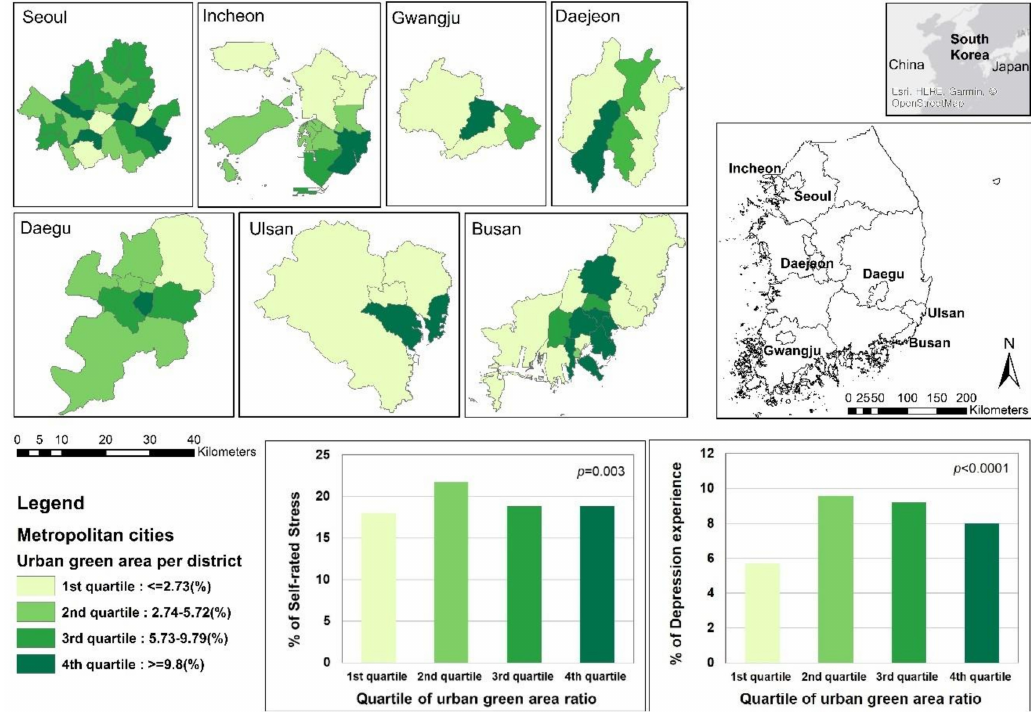
Figure 1. Prevalence of self-rated experiences of stress and/or depression among Koreans aged 65 and over within quartile divisions of urban green areas in seven Korean